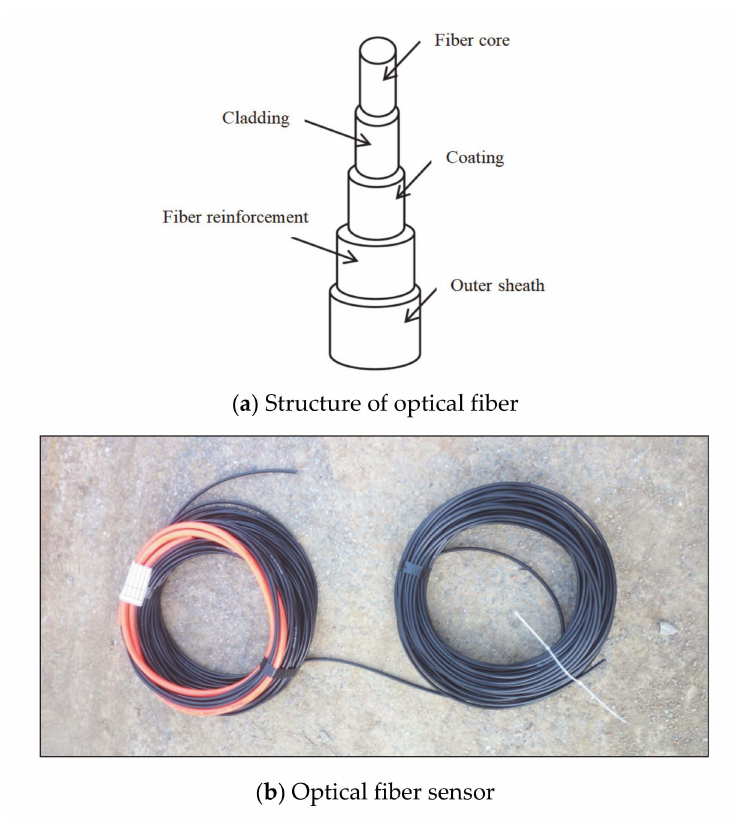
Figure 1. Structure of optical fiber and